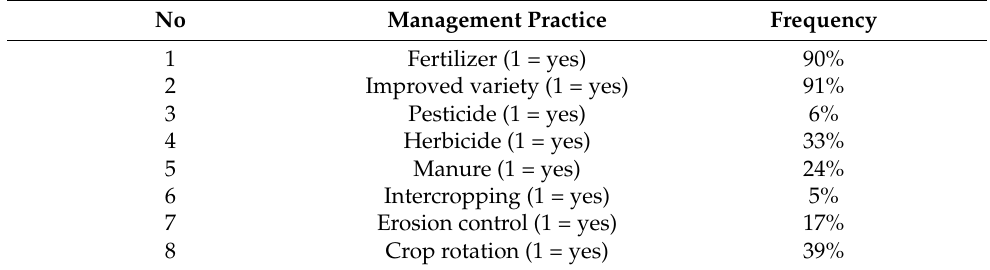
Table 1. Frequency of using individual management practices on sample maize fields (n = 3914).